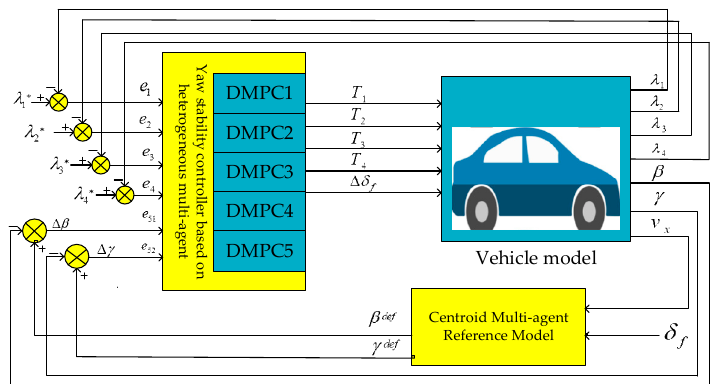
Figure 1. The overall architecture of the system.